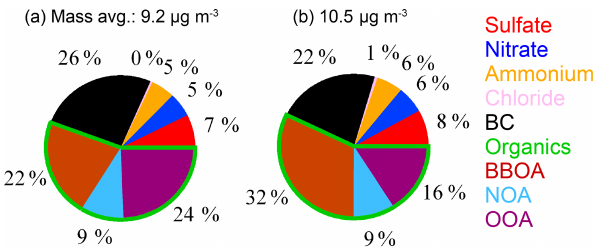
Figure 1. The average mass concentration (mass avg.) and chemi- cal composition of PM 1 during P1 (a) and P2 (b) periods, respec- tively, measured by the HR-ToF-AMS and PAX. Note that the com- pounds of PM 1 include sulfate, nitrate, ammonium, chloride, BC (black carbon), organics, BBOA (biomass-burning-emitted OA), NOA (nitrogen-containing OA), and OOA (oxidized oxygenated